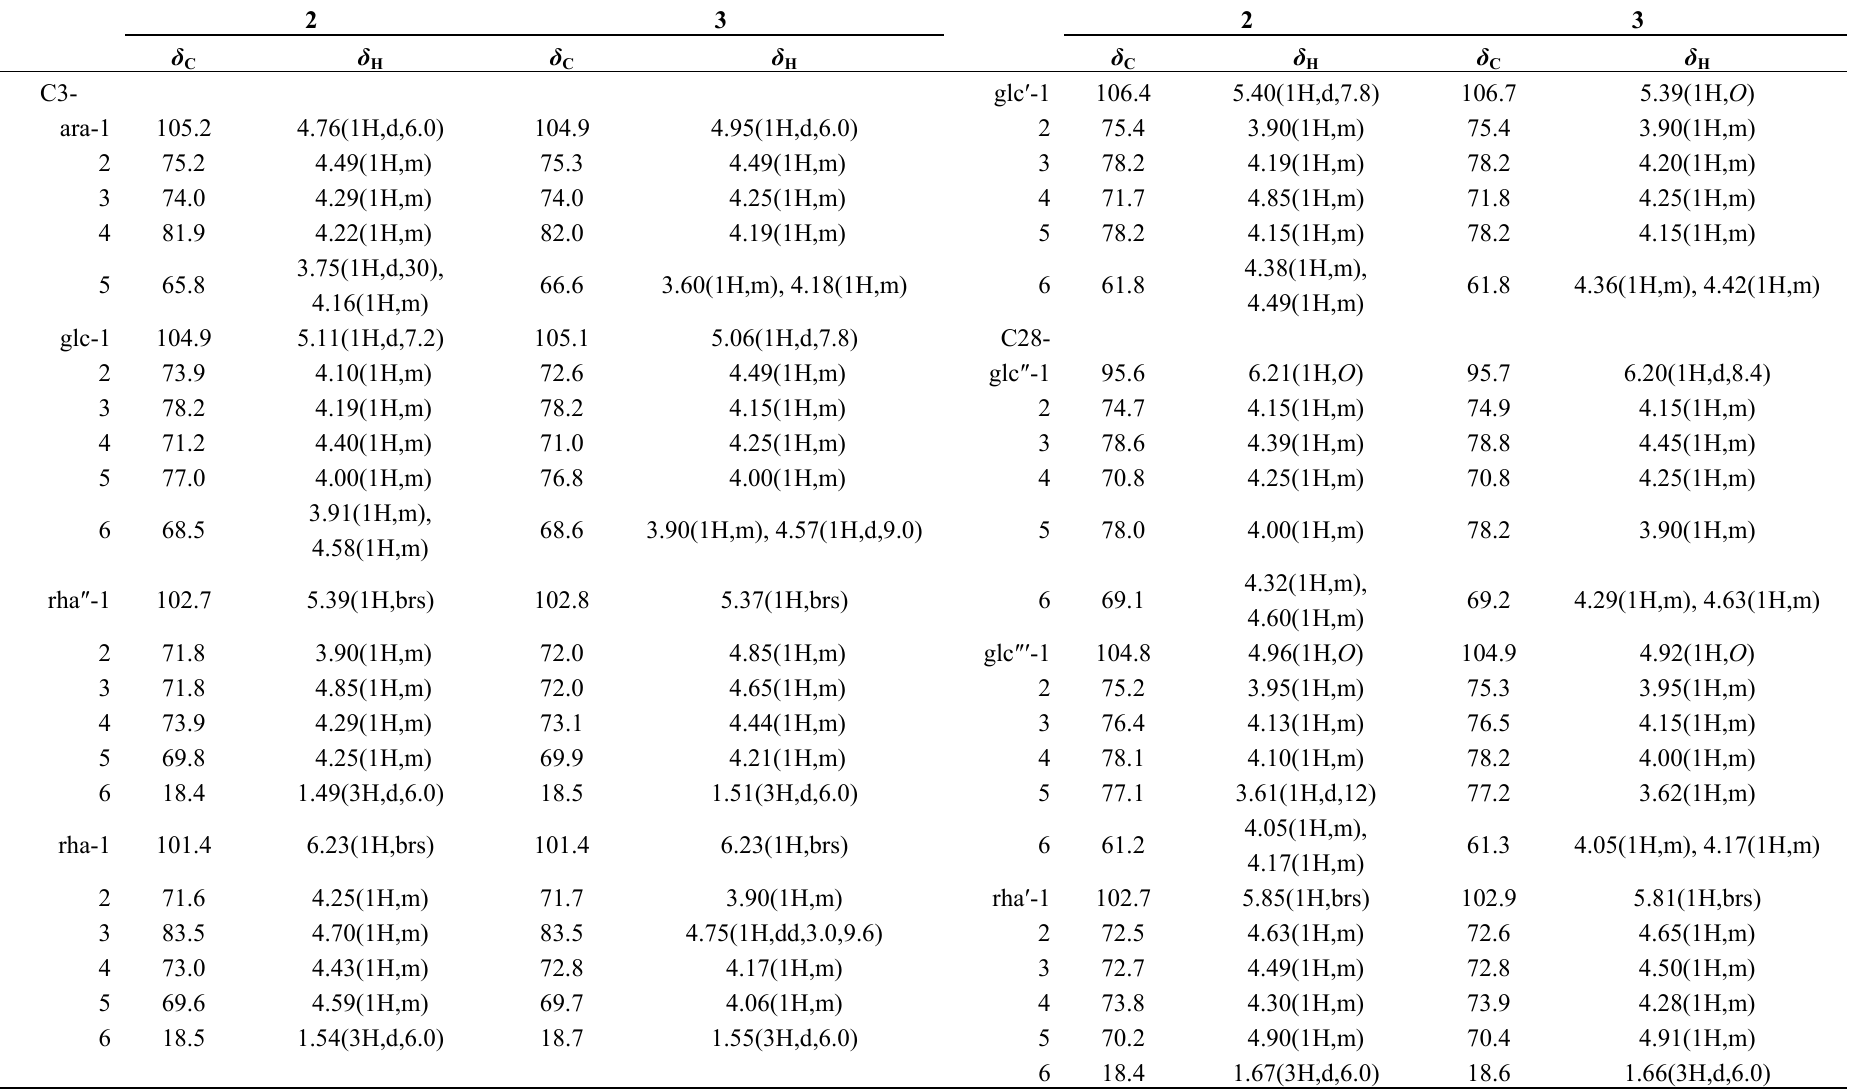
Table 2. Spectroscopic data of 2 and 3 (sugar moieties, δ in ppm, J in Hz) in pyridine- d